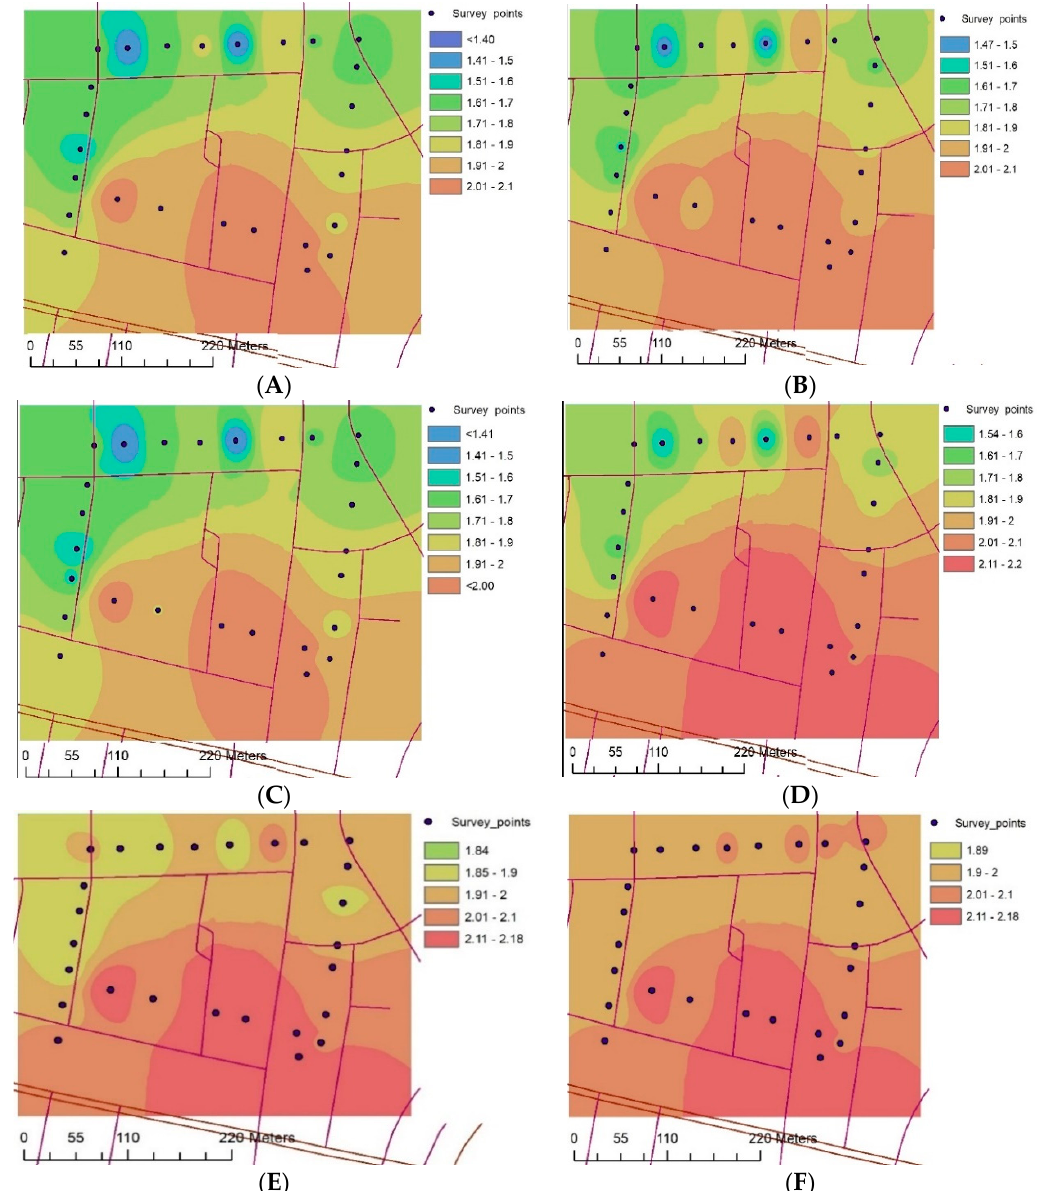
Figure 6. Estimated PLQI response to plausible changes in different input variables (see text for explanations). ( A ) Traffic = 0 & Vegetation = 0; ( B ) Traffic = 1 & Vegetation = 0; ( C ) Traffic = 1 & Vegetation = 1; ( D ) Traffic = 2 & Vegetation = 0; ( E ) Traffic = 2 & Vegetation = 0, Horizontal illuminance ≥ 10 lx; ( F ) Traffic = 2 & Vegetation = 0, Horizontal illuminance ≥ 15 lx; Notes: The estimates are based on Model 3 (Table 2); the maps are produced using the IDW interpolation method.